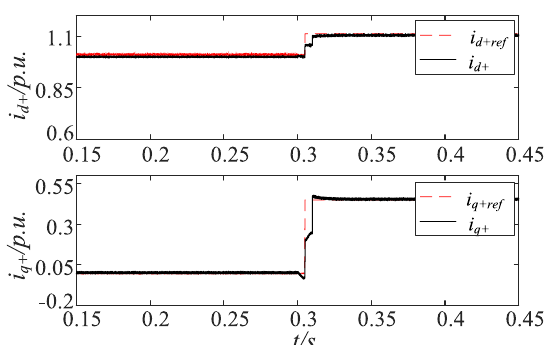
Fig. 18 Positive sequence dq -axis current when the voltage drops under full load condition